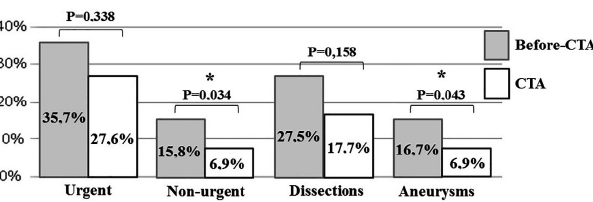
Fig. 2 - Mortality according to urgency and to disease